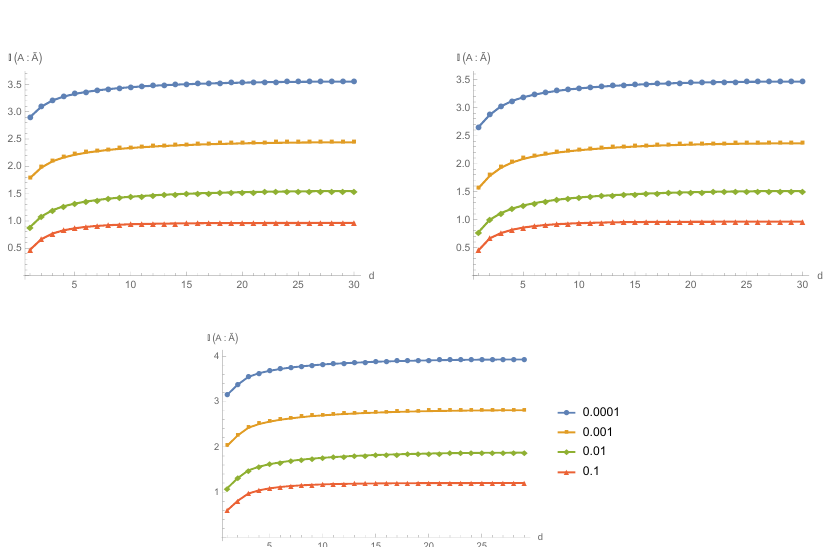
Figure 15 . The left, central and the right one show I ( A : ~ A ) for j A j = j B j = 1 , j A j = 1 ; j B j = 2 and j A j = j B j = 2 respectively, each for m=0.0001,0.001,0.01,0.1 indicated by di(cid:11)erent colors in each of the plots.